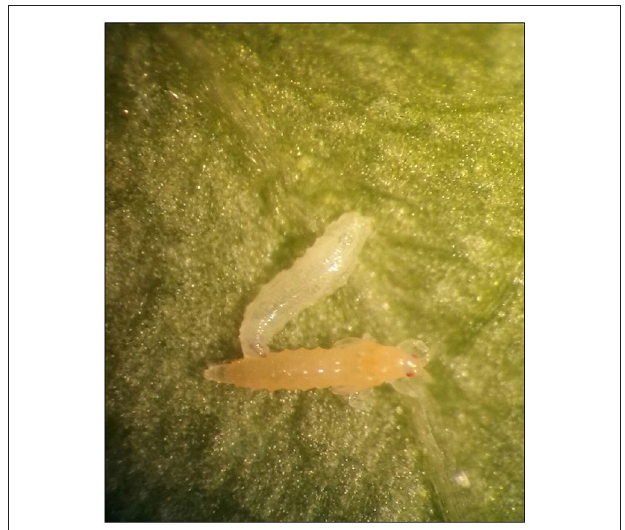
FIGURE 7 | First instar of S. rueppellii larva feeding on F. occidentalis second instar larva.